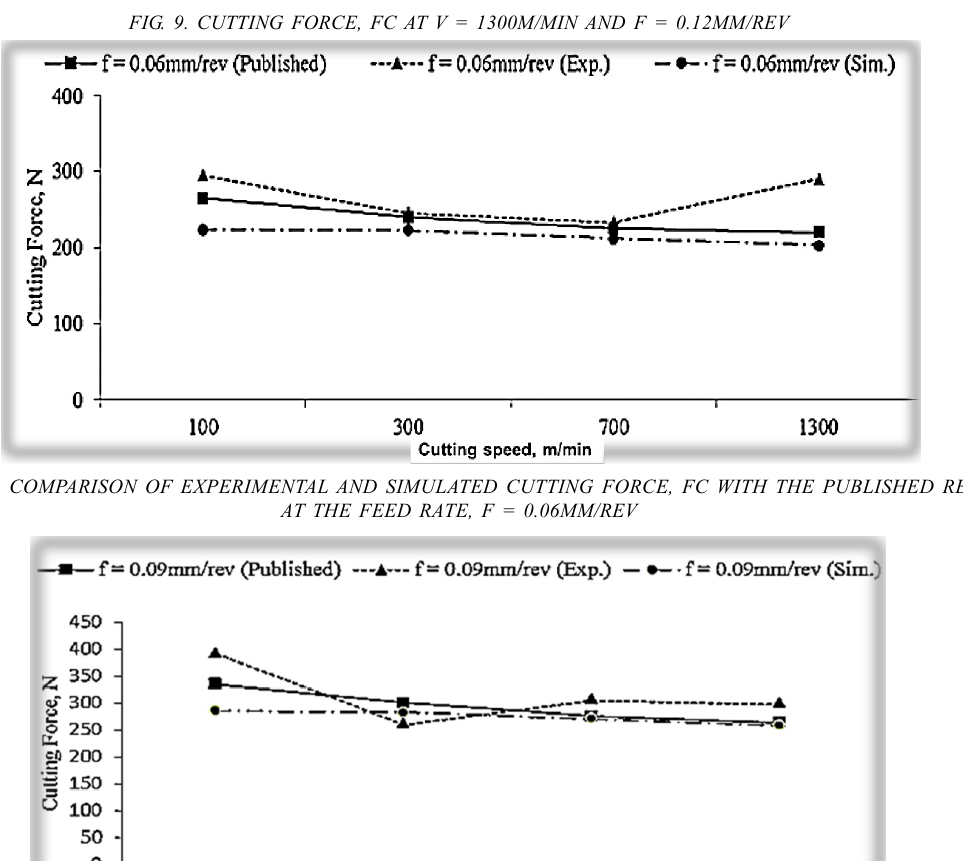
FIG. 9. CUTTING FORCE, FC AT V = 1300M/MIN AND F = 0.12MM/REV